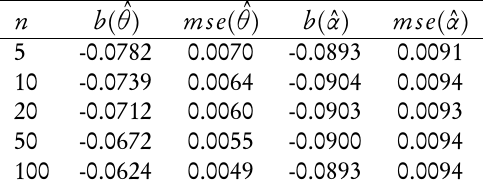
Bias and mean square error of the m.l.e.’s ( ˆ θ , ˆ α ) , for the intermediate binomial distribution { ˆ q ( θ , α ) } , with an approximation of the normalizing constant, θ = 0.5 , m = 20 , and α = 0.35 . i